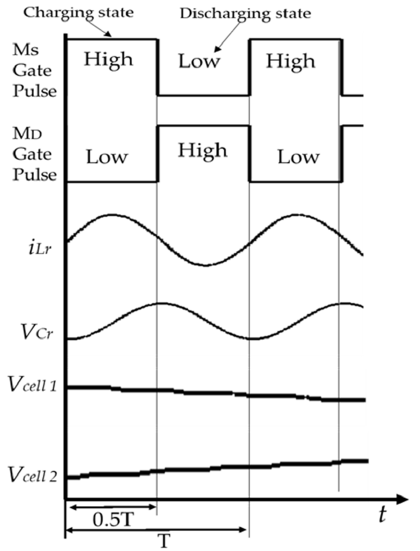
Figure 5. Analytical waveforms of MOSFET switches, resonant inductor current capacitor voltage, and cell voltages in the working modes.